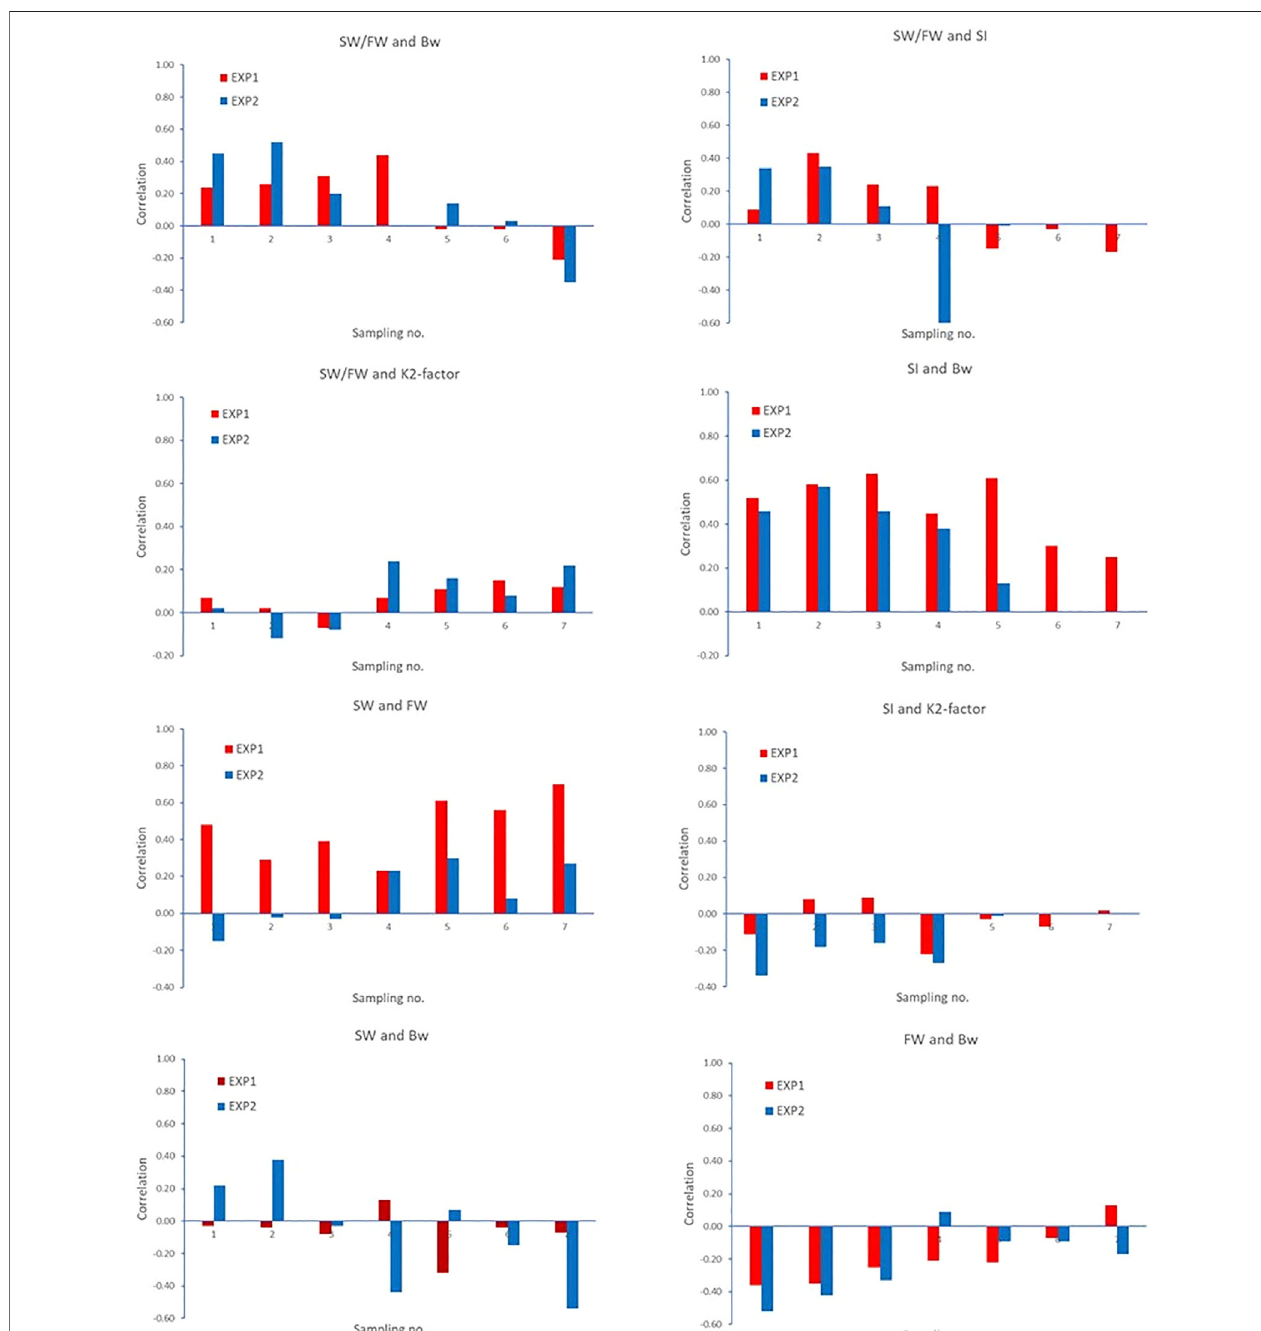
FIGURE 5 | Correlations between some selected pair of traits within each of the seven samplings. Correlation − 0.254 > r > 0.254 (EXP1, N (cid:2) 100 fi sh recorded/ sampling) and − 0.325 > r > 0.325 (EXP2, N (cid:2) 2 × 30 fi sh recorded/sampling) are signi fi cantly different from zero ( p < 0.05).